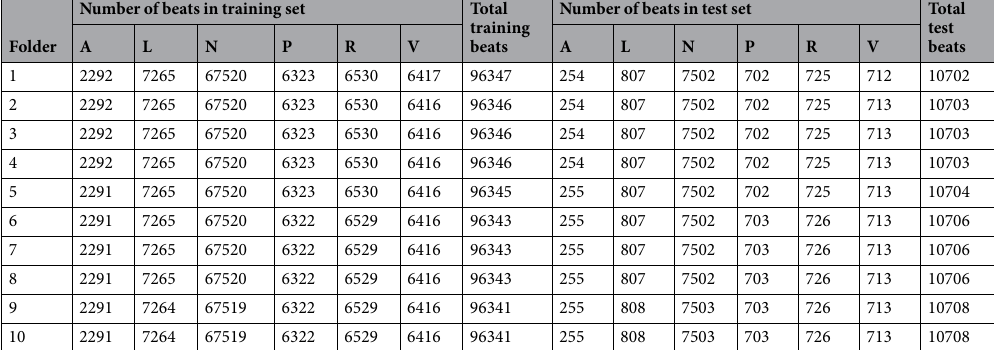
Table 1. Data profile for the beat-based 10-fold cross validation scheme.